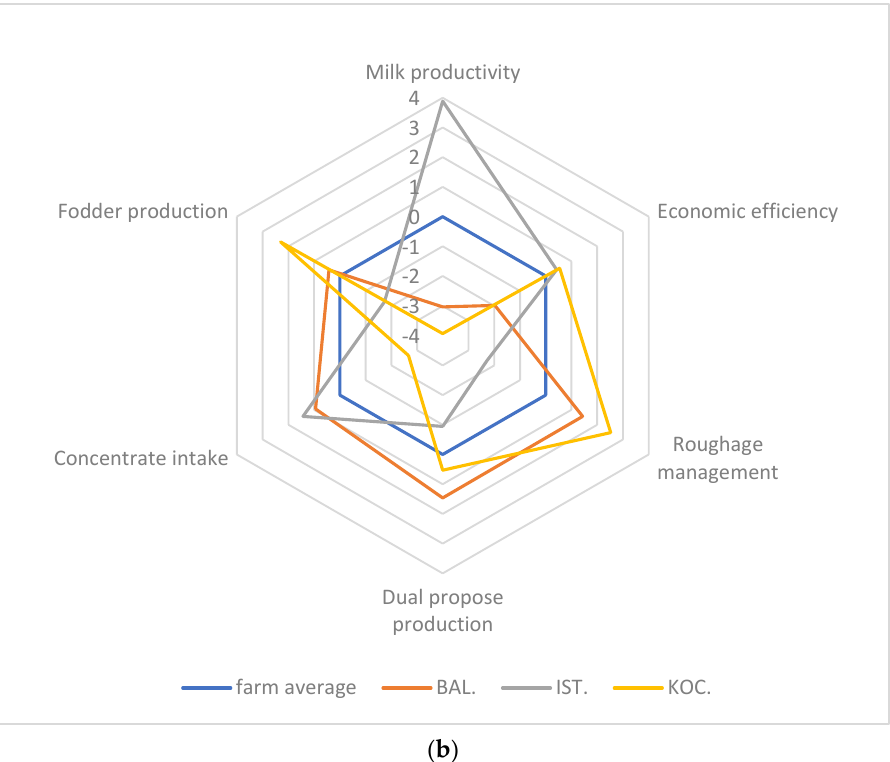
Figure 2. ( a ) Comparison of the randomly selected farm performances in relation to the extracted factors obtained from the PCA. Performance of a farm should be compared with the average farm. ( b ) Comparison of the territorial performances in relation to the extracted factors obtained from the PCA. In the chart, BAL. represents Balikesir, IST. Represents Istanbul, and KOC. represents Kocaeli.